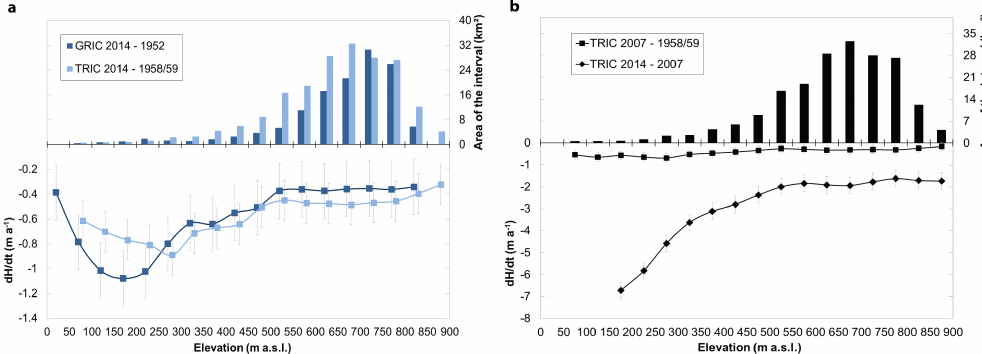
Figure 6. (a) Historical averaged elevation change rates (d H /d t avg ) measured for GRIC (1952–2014) and TNIC (1958/59–2014) for each 50m elevation band. (b) Historical (1959–2007) and recent (2007–2014) d H /d t avg for each 50m elevation band on TNIC. The error margins are the elevation change measurement uncertainties determined in Sect.